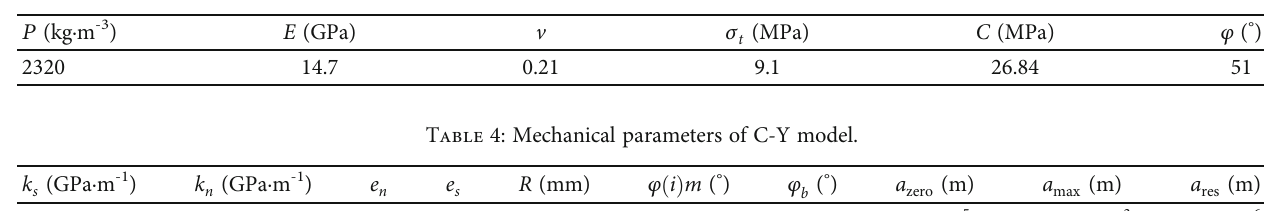
Figure 19: Numerical model of single joint and cloud diagram of seepage pressure distribution. Table 3: Parameters of M-C model.